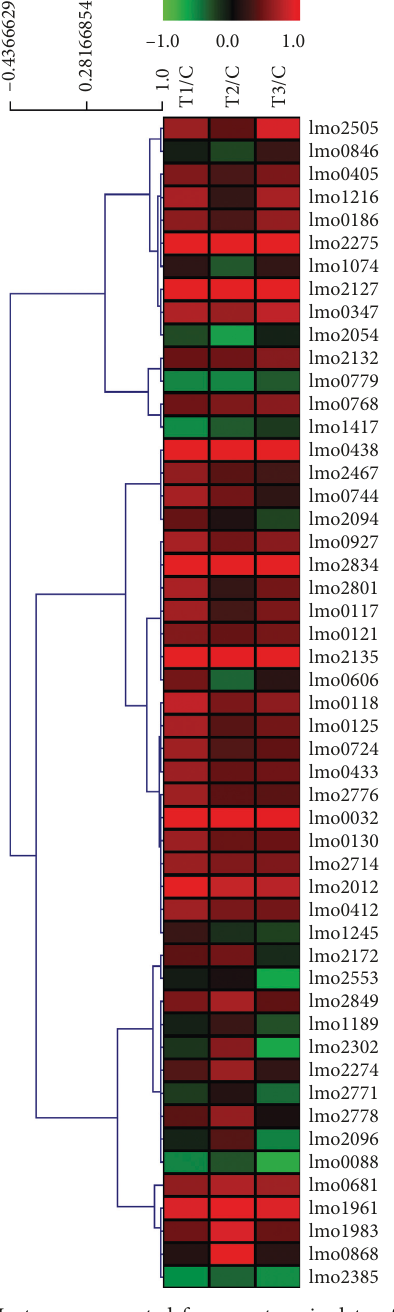
Figure 3: Heat map generated from proteomic data of totally 51 significantly differentially expressed proteins organized by each rows of individual proteins using hierarchical clustering. The identity of each protein can be found in Table 1. The proteins that increased and decreased in abundance are indicated in red and green, respectively. Complete linkage analysis was used to cluster biological replicate data and proteins data relative to each other. Time points T1, T2, and T3 represents 5min, 30min, and 1hr cultures after the low pH (3.5) and high water activity (0.90) treatments of early stationary phase